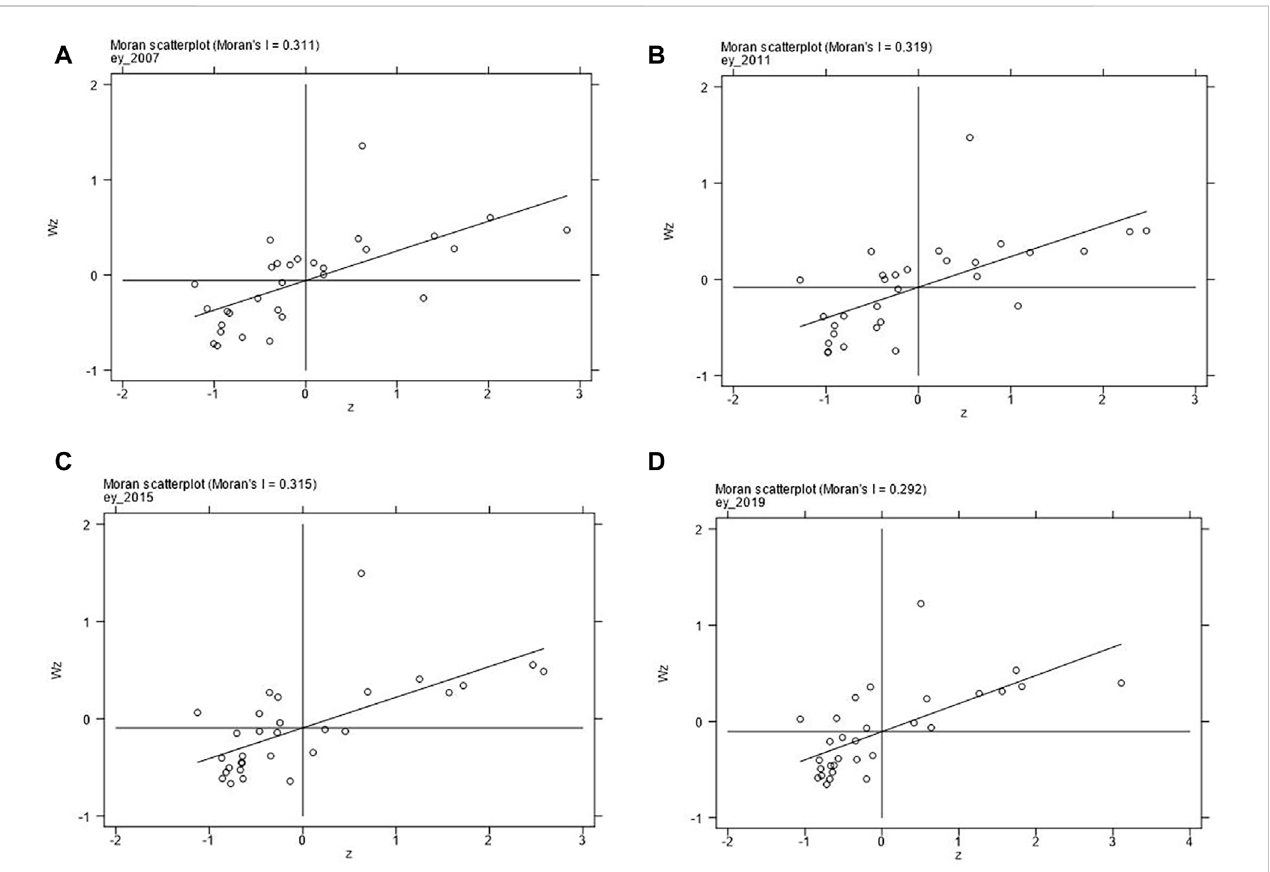
FIGURE 2 The scatter plots of Moran ’ s I index of energy